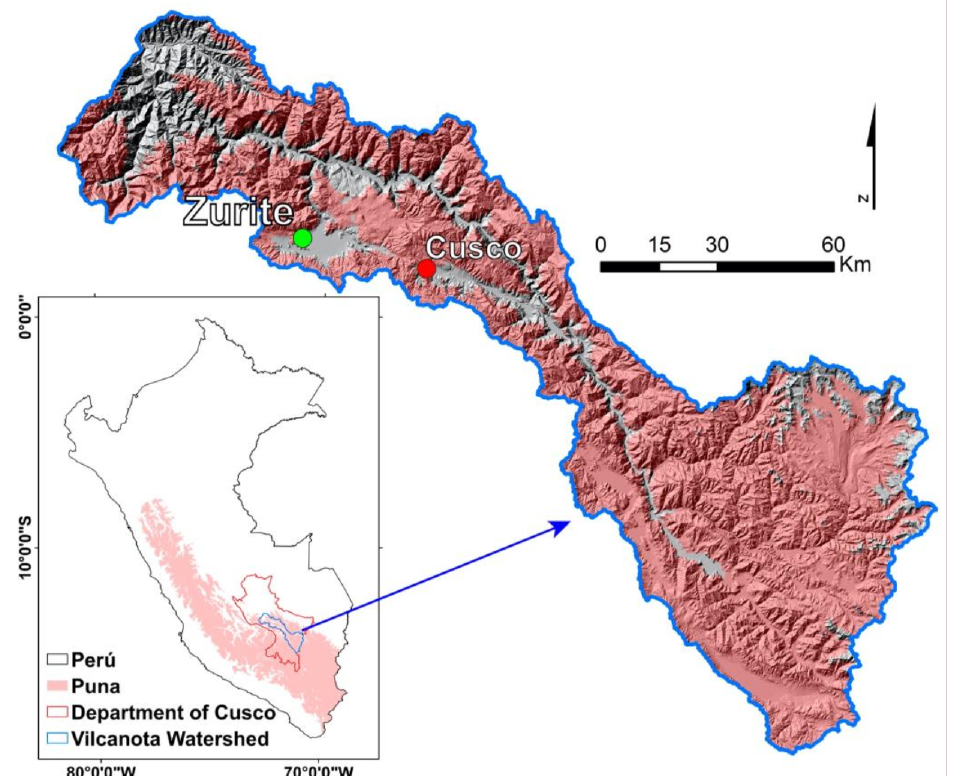
Figure 2. Zurite is located approximately 40 km to the northwest of Cusco, within the 11,048 km 2 Vilcanota Watershed [8]. The Vilcanota flows to the NW and is entirely within the Department of Cusco, outlined in red on the inset map. Red shading indicates the extent of the puna biome in Per ú and within the Vilcanota Watershed [25]. The Sacred Valley is the gray region (lower elevation than the puna) directly north of Cusco and